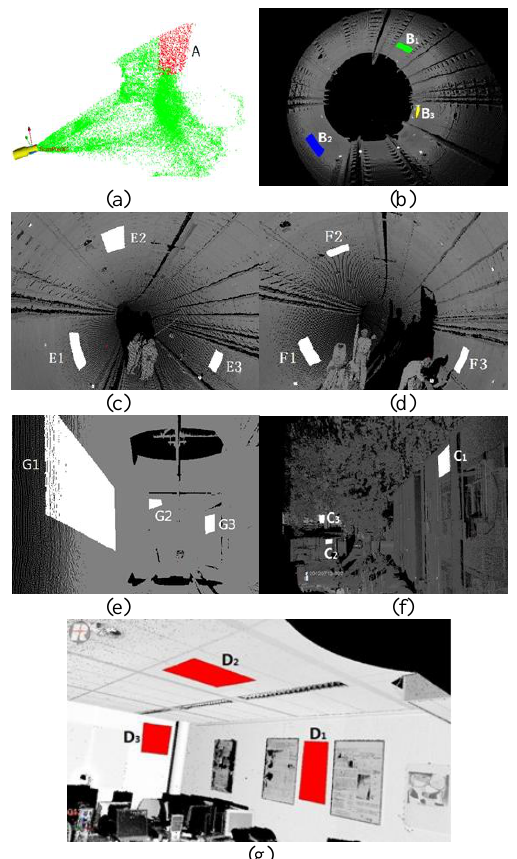
Figure 5. Selected surface segments for registration quality evaluation. (a) Dataset 1; (b) Dataset 2 (Point cloud pair I- II); (c) Dataset 2 (Point cloud pair II-III); (d) Dataset 2 (Point cloud pair III-IV); (e) Dataset 2 (Dataset 2 (Point cloud V-VI); (f) Dataset 3; (g) Dataset 4.